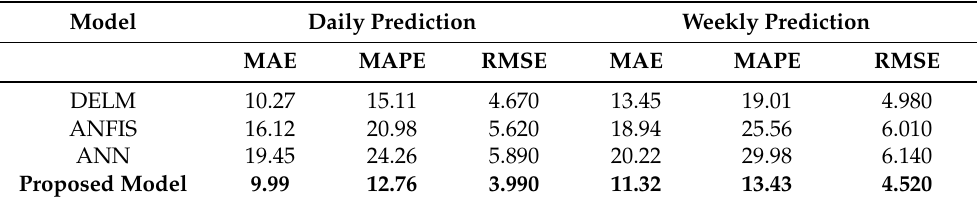
Table 6. Comparative analysis of proposed ensemble model with DELM, ANFIS, ANN on daily and weekly apartment level forecasting without